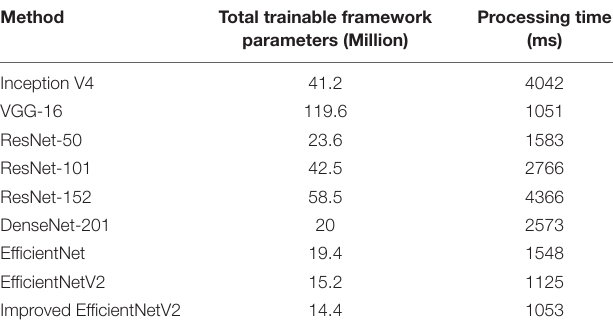
TABLE 4 | Comparative analysis of proposed approach in terms of computational complexity with the base